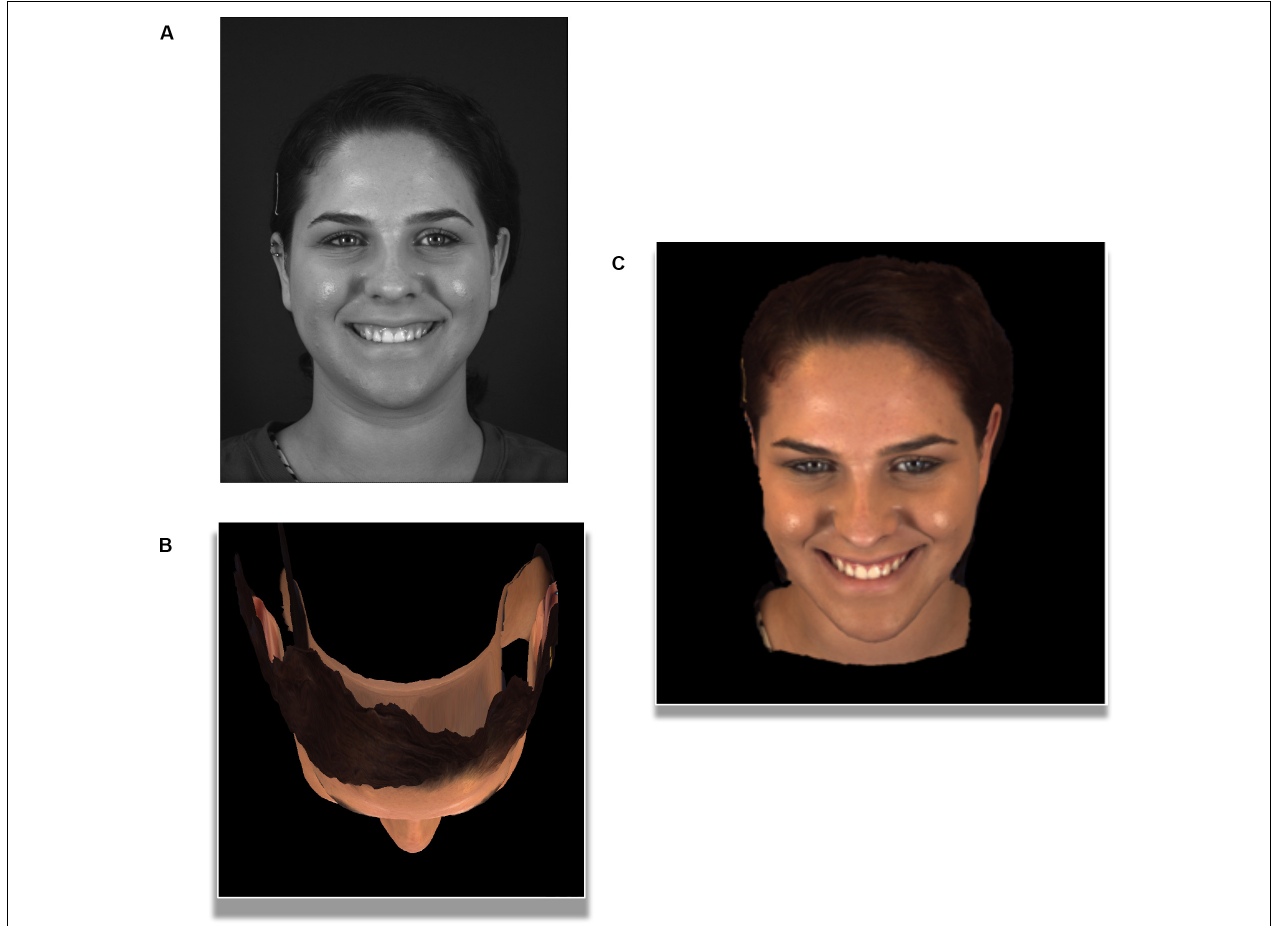
FIGURE 2 | 2D image compared to the 4D video-frame of a highly cited 4D facial database (The images pictured above were reproduced, modified and adapted from the facial database originally developed by Zhang et al. (2013; 2014). Copyright 2013–2017, The Research Foundation for the State University of New York and University of Pittsburgh of the Commonwealth System of Higher Education. All Right Reserved. BP4D-Spontaneous Database, as of: 26/03/2018. (A) A flattened face. Traditional camera set-up produces a 2D image or photograph in gray-scale. (B) A bird’s eye view of 3D geometric mesh. Multi-view camera set-up producing a 3D structured facial mesh, with skin texture, using 30,000–50,000 vertices (viewed from top of skull). (C) A 3D sense of re-created depth. Despite being on a two-dimensional computer screen, a 3D face reconstructed with multi-view camera set-up, produced an illusion of depth. The final reconstruction produces the same facial model, which stands out from the background and appear more lifelike than the 2D photograph. When working with 3D facial stimuli, we can change our viewpoint of the facial stimulus. Here we have manipulated the viewer angle of the camera along a Z -axis is possible (top-frontal view), to view the same frame of a face from many possible 360 degree